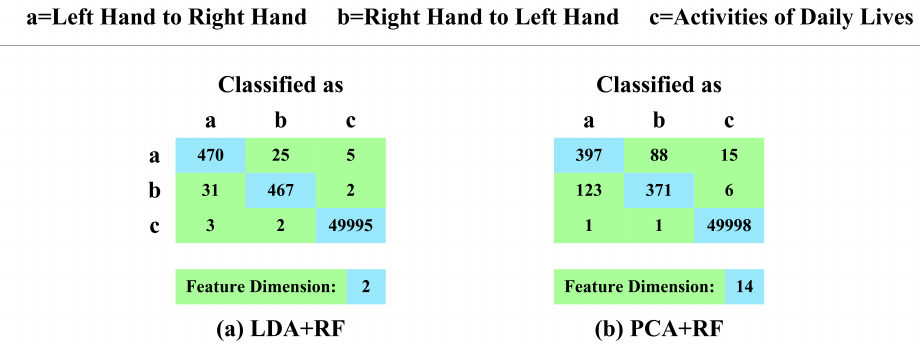
Figure 23. Confusion matrices and feature dimensions of RF along with LDA and PCA.